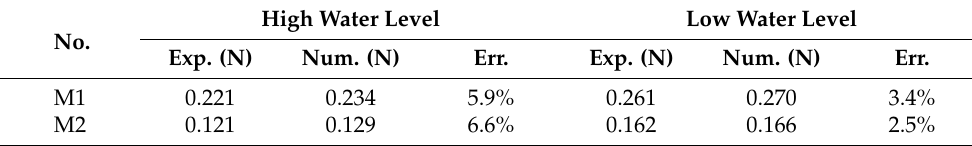
Table 1. Maximum tension force on mooring lines for the trash-blocking net in current.